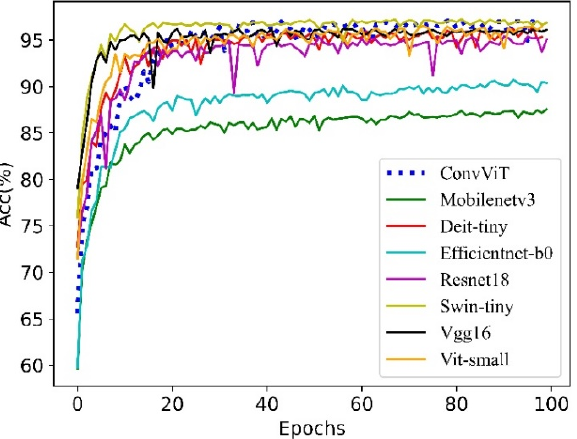
Figure 9. Performance comparison with the state-of-the-art methods. All the models start to converge at 20 epochs and finally converge to stability at 100 epochs. Among all the models, Swin-tiny [17] obtained the highest recognition accu- racy of 96.94%, our model ranked second with 96.85%, and MobilenetV3 [21] obtained the lowest recognition accuracy of 87.42%. The recognition results of the model based on the Transformer structure are generally better than those of the model based on the CNN architec- ture. We conjecture that this is related to the complex background information of the dataset, and the Transformer structure-based model can establish the long-distance dependence of the disease images, reducing the complex background’s effect on the recognition